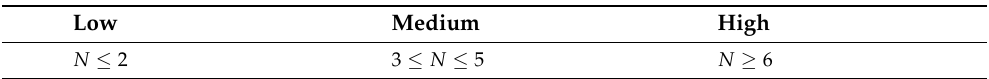
Table 5. “Wealth of functionality” rating scale. N indicates the number of functions provided by the tool described in table.